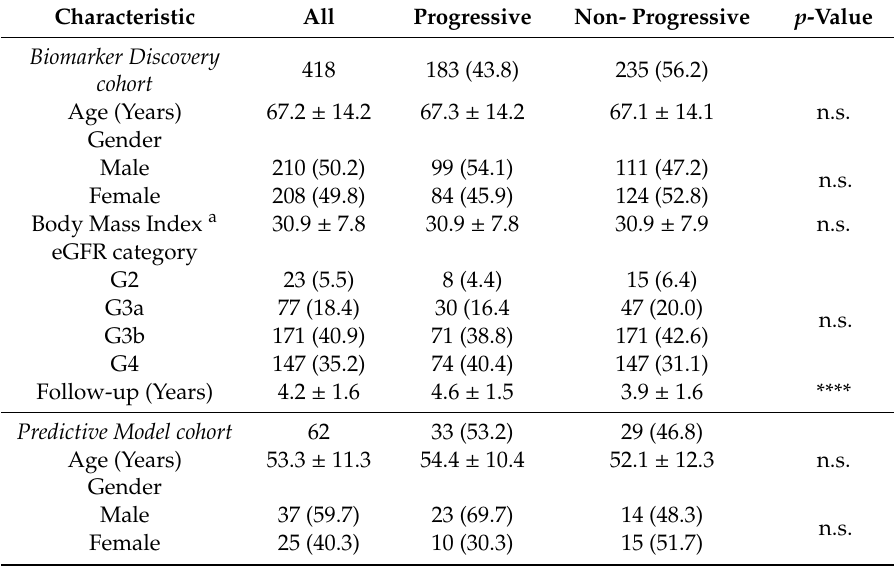
Table 1. Patient Characteristics of the Biomarker Discovery and Predictive Model cohorts.